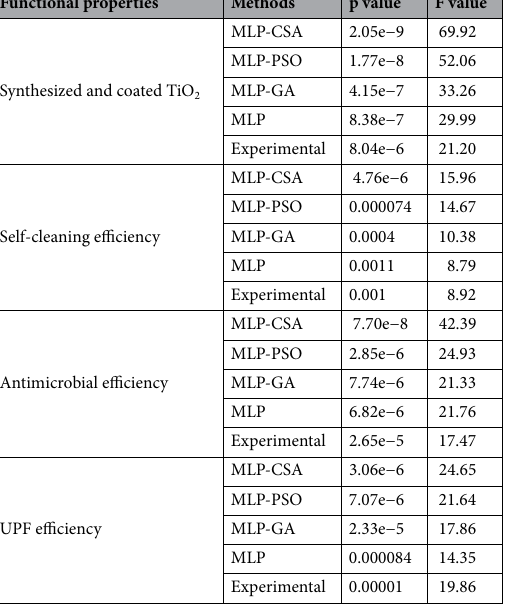
Functional properties